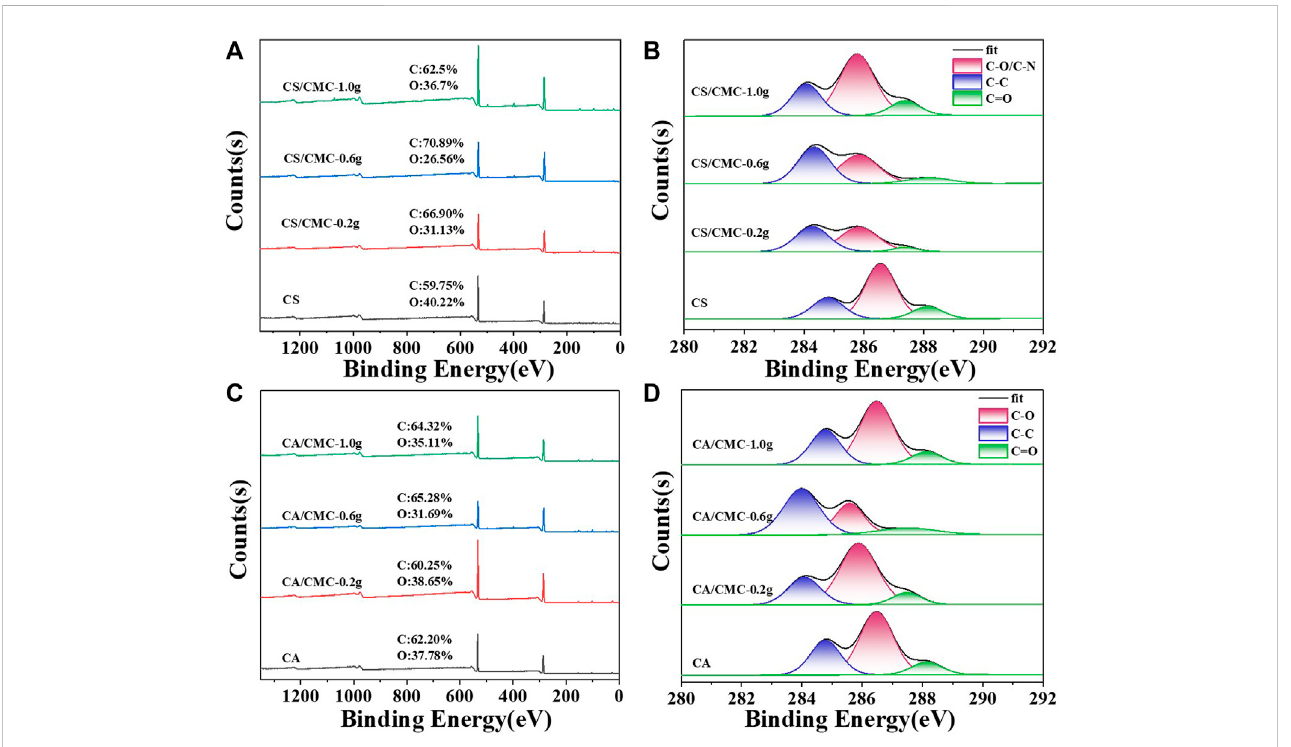
FIGURE 7 XPS survey spectra and high-resolution C1s spectra of the starch/CMC composite fi lms. (A, C) : CS/CMC composite fi lms; (B, D) : CA/CMC composite fi lms.